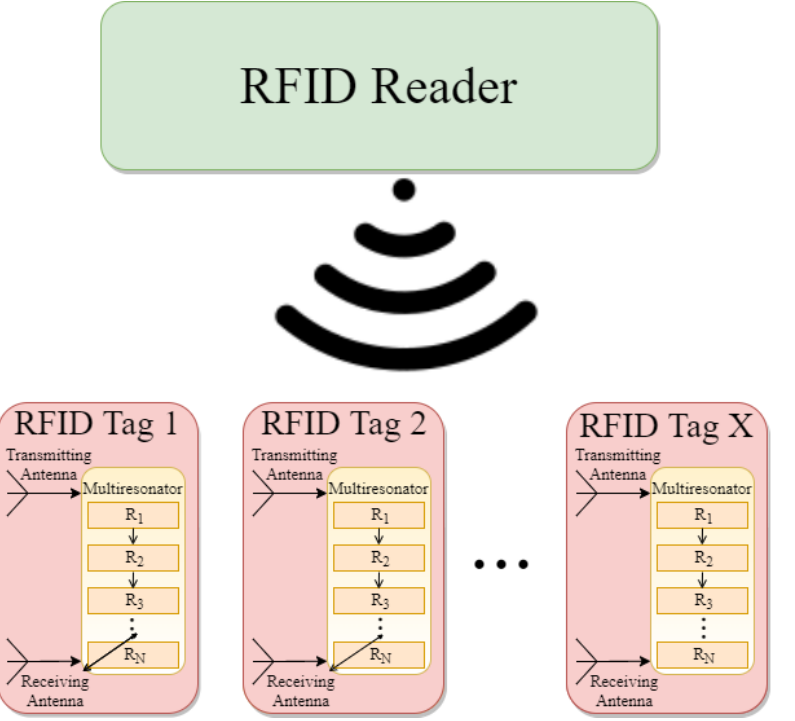
Figure 1. Schematic of an RFID